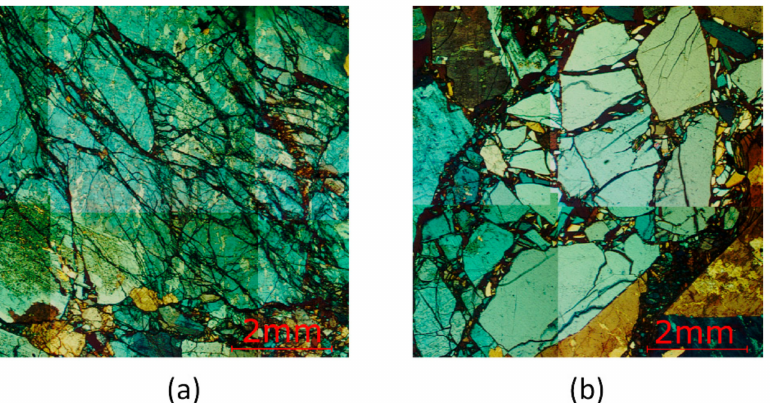
Figure 7. Areas with shattered minerals after the particle bed comminution: ( a ) Fragments of fine shattered feldspar; ( b ) Fragments of coarser shattered quartz. The quartz fragments are in the center of the image and can be identified by their less textured and more bright bluish